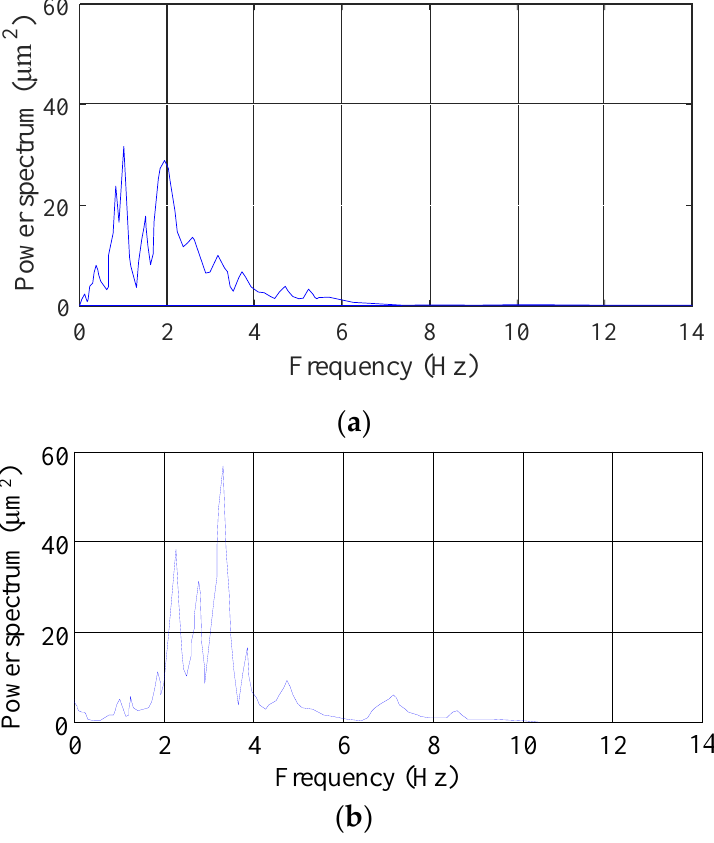
Figure 14. Fourier spectrum of denoised signal at orifice ( a ) and T9 ( b ).